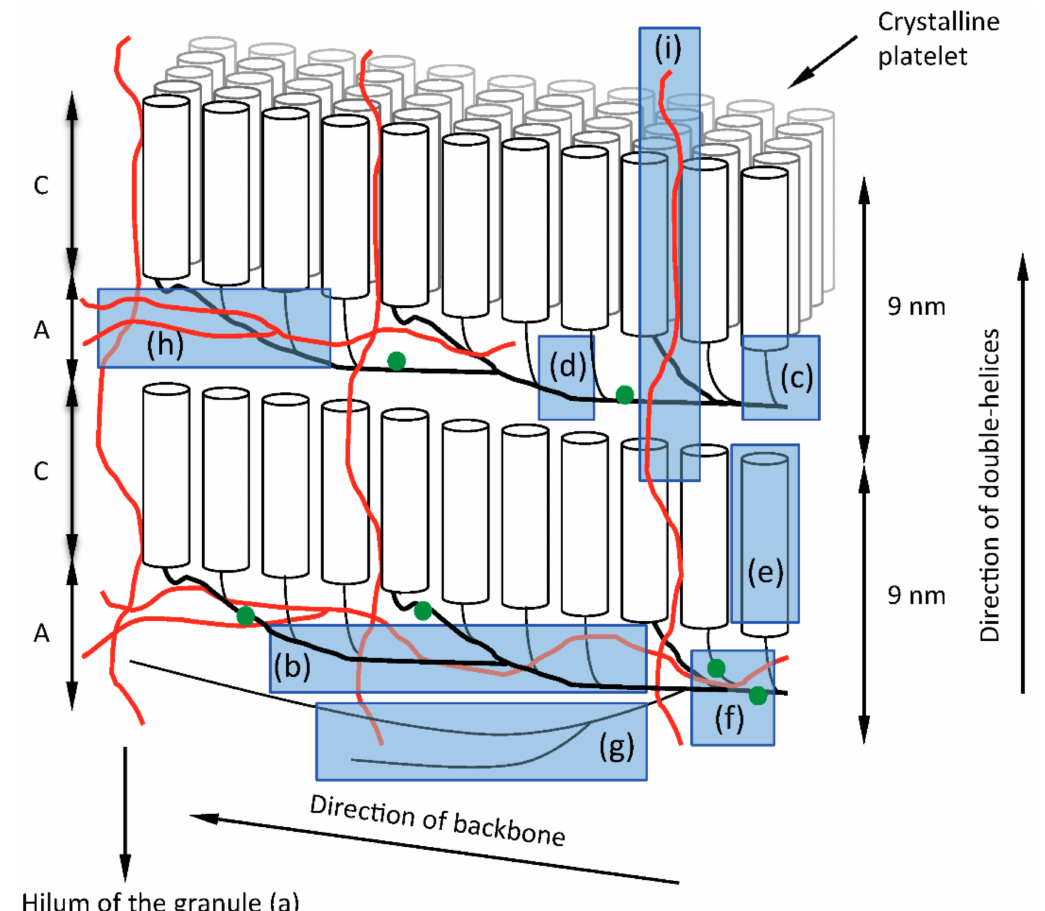
Figure 4. A cartoon of the building block backbone model of amylopectin with its structural elements in the starch granule along with the possible involvement of amylose. Stacks of amorphous (A) and crystalline lamellae (C) are indicated with a repeat distance of approximately 9 nm. Layers of amylopectin molecules are laid upon each other during the biosynthesis and crystalline platelets are formed by the double-helices (cylinders) as indicated in the 3D-view. The non-reducing ends of the double-helices are directed toward the granule surface and the hilum of the granule ( a ) is found in the other direction. Amylose (red lines) is suggested to be found interspersed with the backbone of amylopectin (bold black lines) in the amorphous layers, which increases the stability of the starch granules. Some amylose molecules are also crossing the layers, thereby providing additional stability to the layered structure. The structural elements are highlighted in blue as (b) the backbone, ( c ) building blocks, ( d ) inter-block segments, ( e ) external segments (forming double-helices), ( f ) phosphate groups (green dots), ( g ) super-long chains, ( h ) branched amylose, and ( i ) linear amylose. See also Table 1 which refers to the same structural elements in relation the respective enzymatic reactions responsible for their synthesis. Note that the actual positions of phosphate groups remain